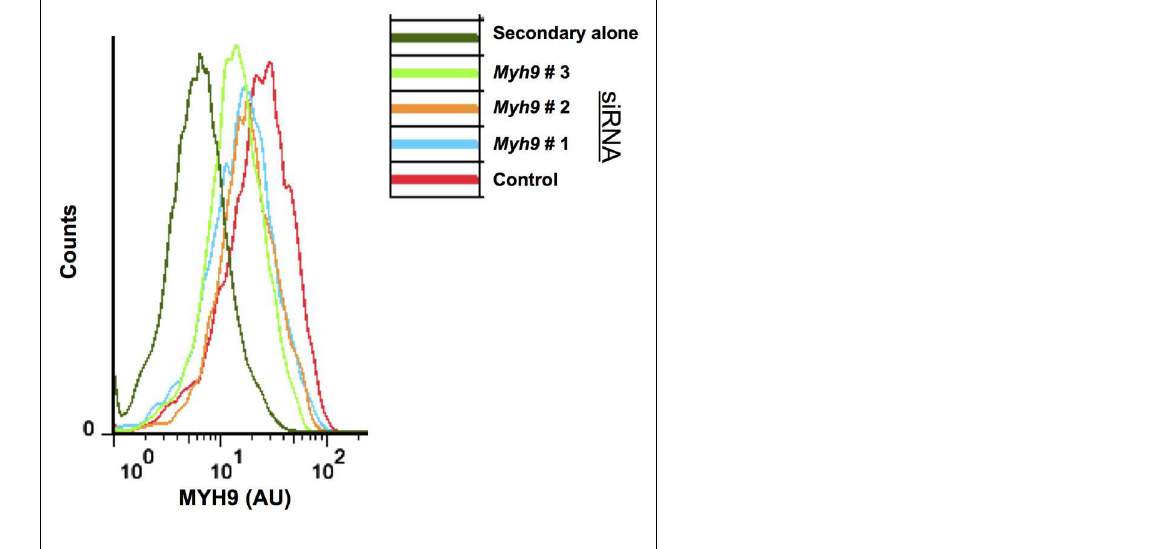
FIGUREA1 | Flow cytometric analysis ofANDT cell blasts electroporated with Myh9 siRNA. Cells electroporated with siRNA were fixed, immunostained for MYH9 protein, and analyzed using flow cytometry. siRNA #1, #2, #3 denotes different Myh9 siRNA sequences, shown in Figure 3A .